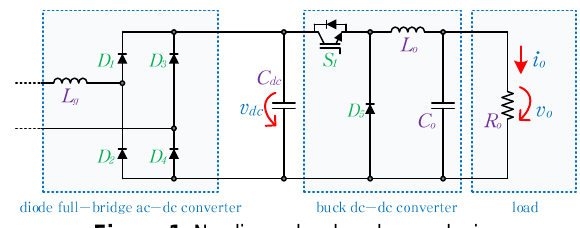
Figure 1 . Nonlinear load under